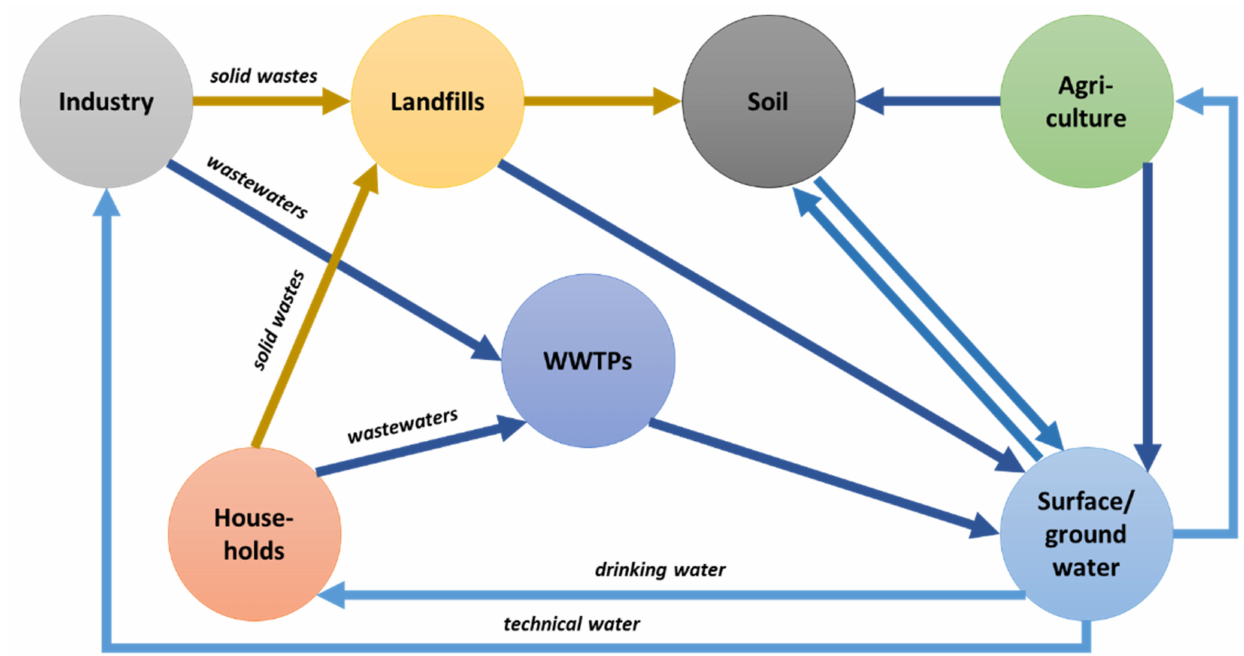
Figure 1. The migration pathways of antibiotics to the environment (according to